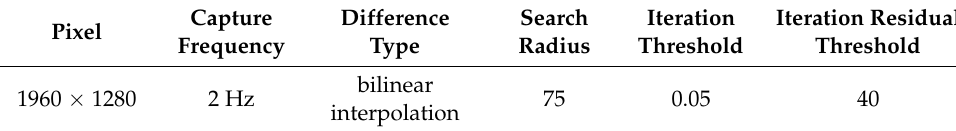
Figure 2. Acoustic emission monitoring system and DIC strain monitoring system. Table 5. Main parameters of the DIC full-field strain monitoring system.